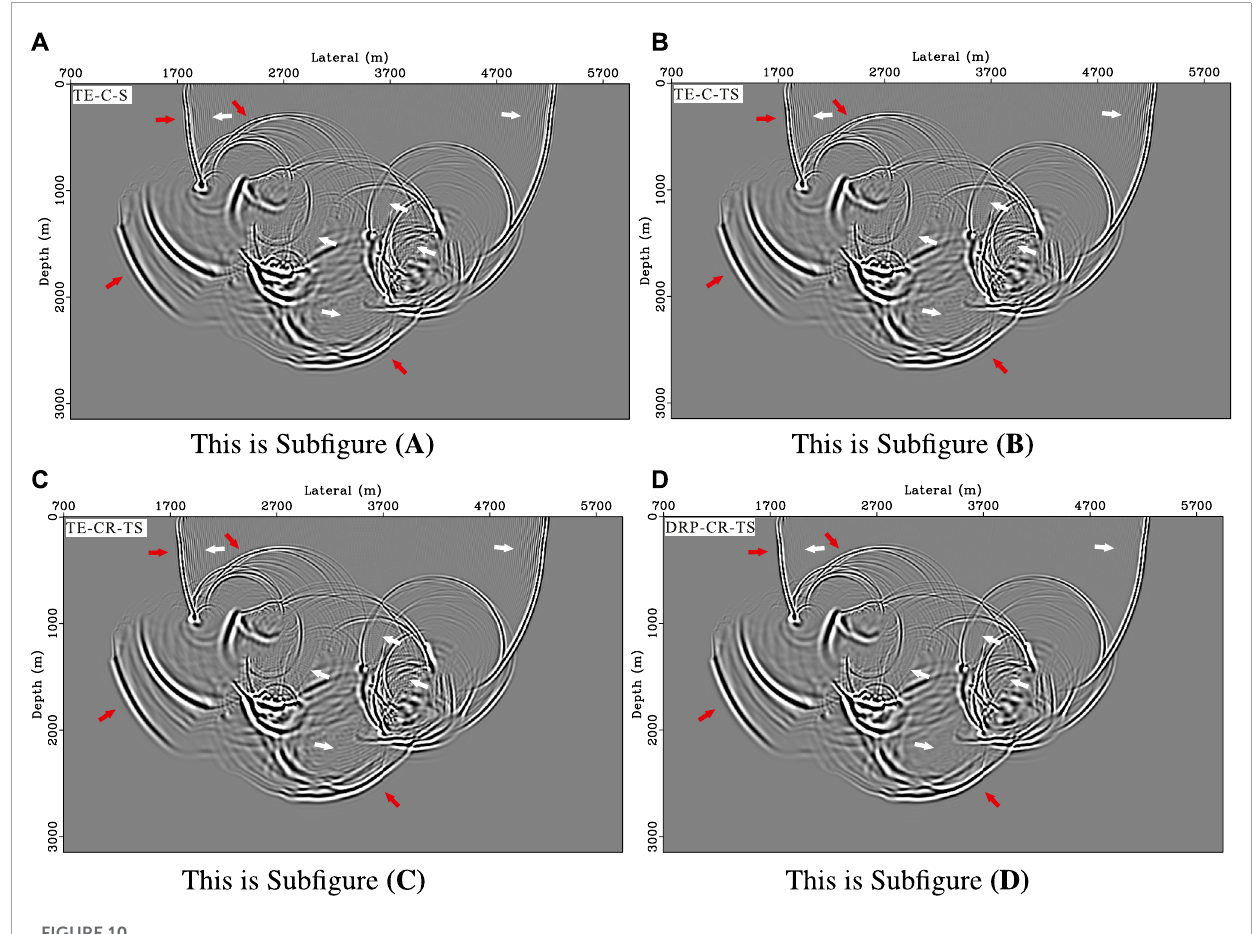
FIGURE 10 Snapshots of the four methods, here we set M = 8 , N = 3 , L = M and τ = 0.007 s (A) TE-C-S method. (B) TE-C-TS method. (C) TE-CR-TS method. (D) DRP-CR-TS method.